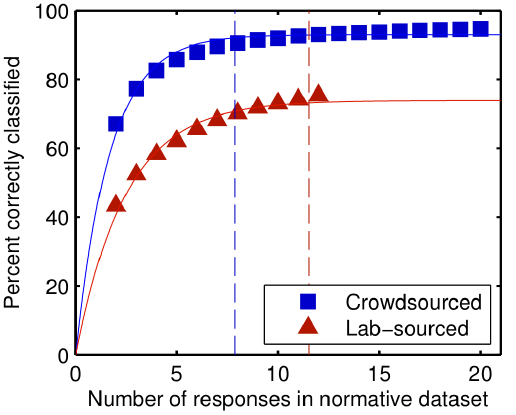
Figure 1. Response classification rate for smaller dataset sizes. Results of simulations on the two datasets for the percent correctly classified when the size of the normative dataset was reduced from its full size of either 20 or 12 responses per video clip. Each point is based on 100 random samples. The solid line indicates the best fit of a two- parameter exponential function, while the dashed line indicates the point at which the function reached 99% of the asymptote.